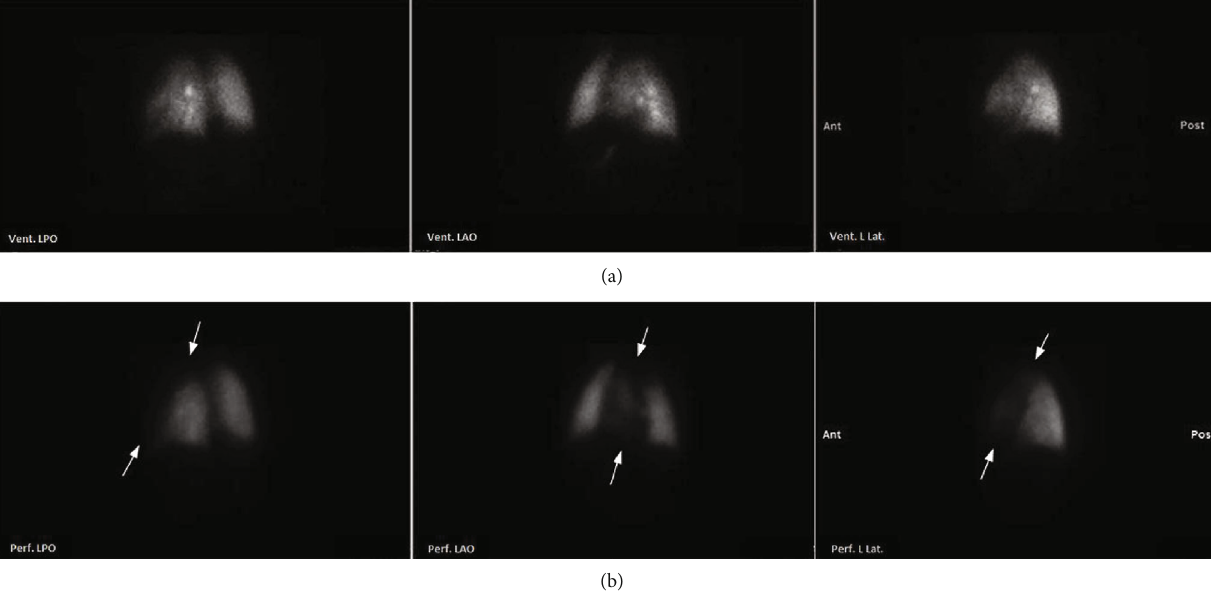
Figure 2: Lung V/Q scan showing absent perfusion of the left upper pulmonary lobe and lingula (arrows) based on the comparison of the relatively (a) normal ventilation to the (b) abnormal perfusion in the left posterior oblique (LPO), left anterior oblique (LAO), and left lateral (L lat.)